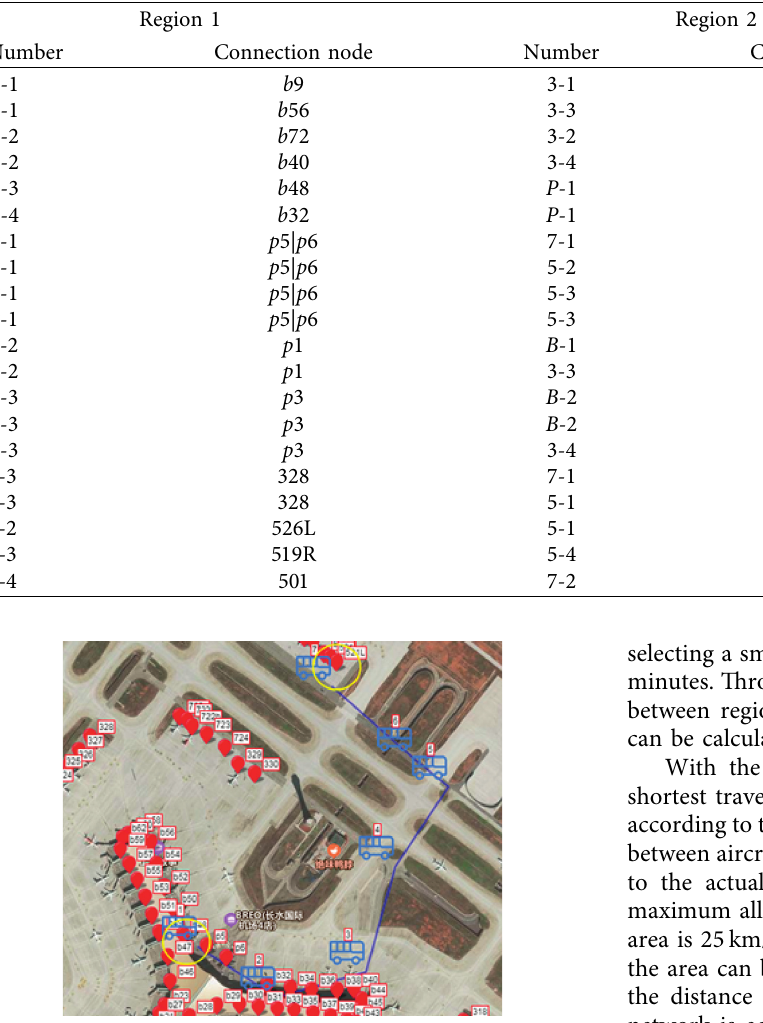
Figure 8: Example of ferry car path